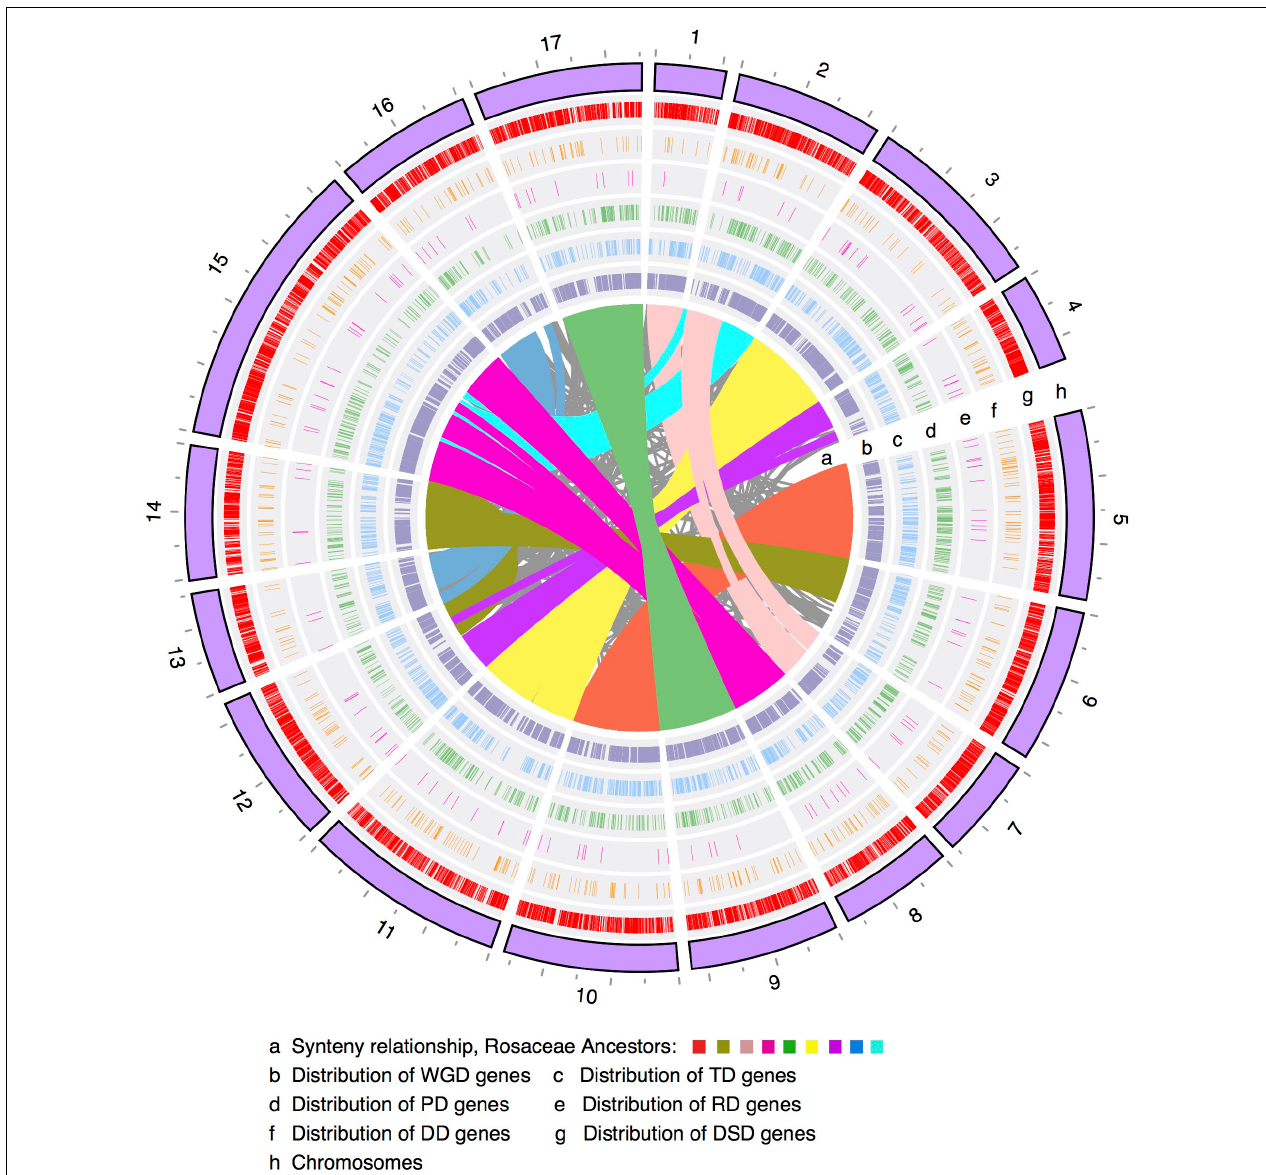
FIGURE 1 | The chromosomal distribution of different modes of duplicated genes. WGD, whole-genome duplication; TD, tandem duplication; PD, proximal duplication; RD, retrotransposed duplication; DD, DNA-transposed duplication; DSD, dispersed